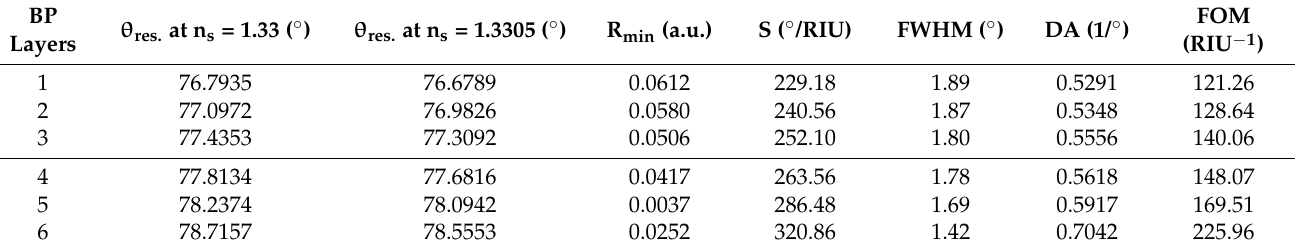
Table 2. Sensor parameters evaluated for 0–6 layers of BP.